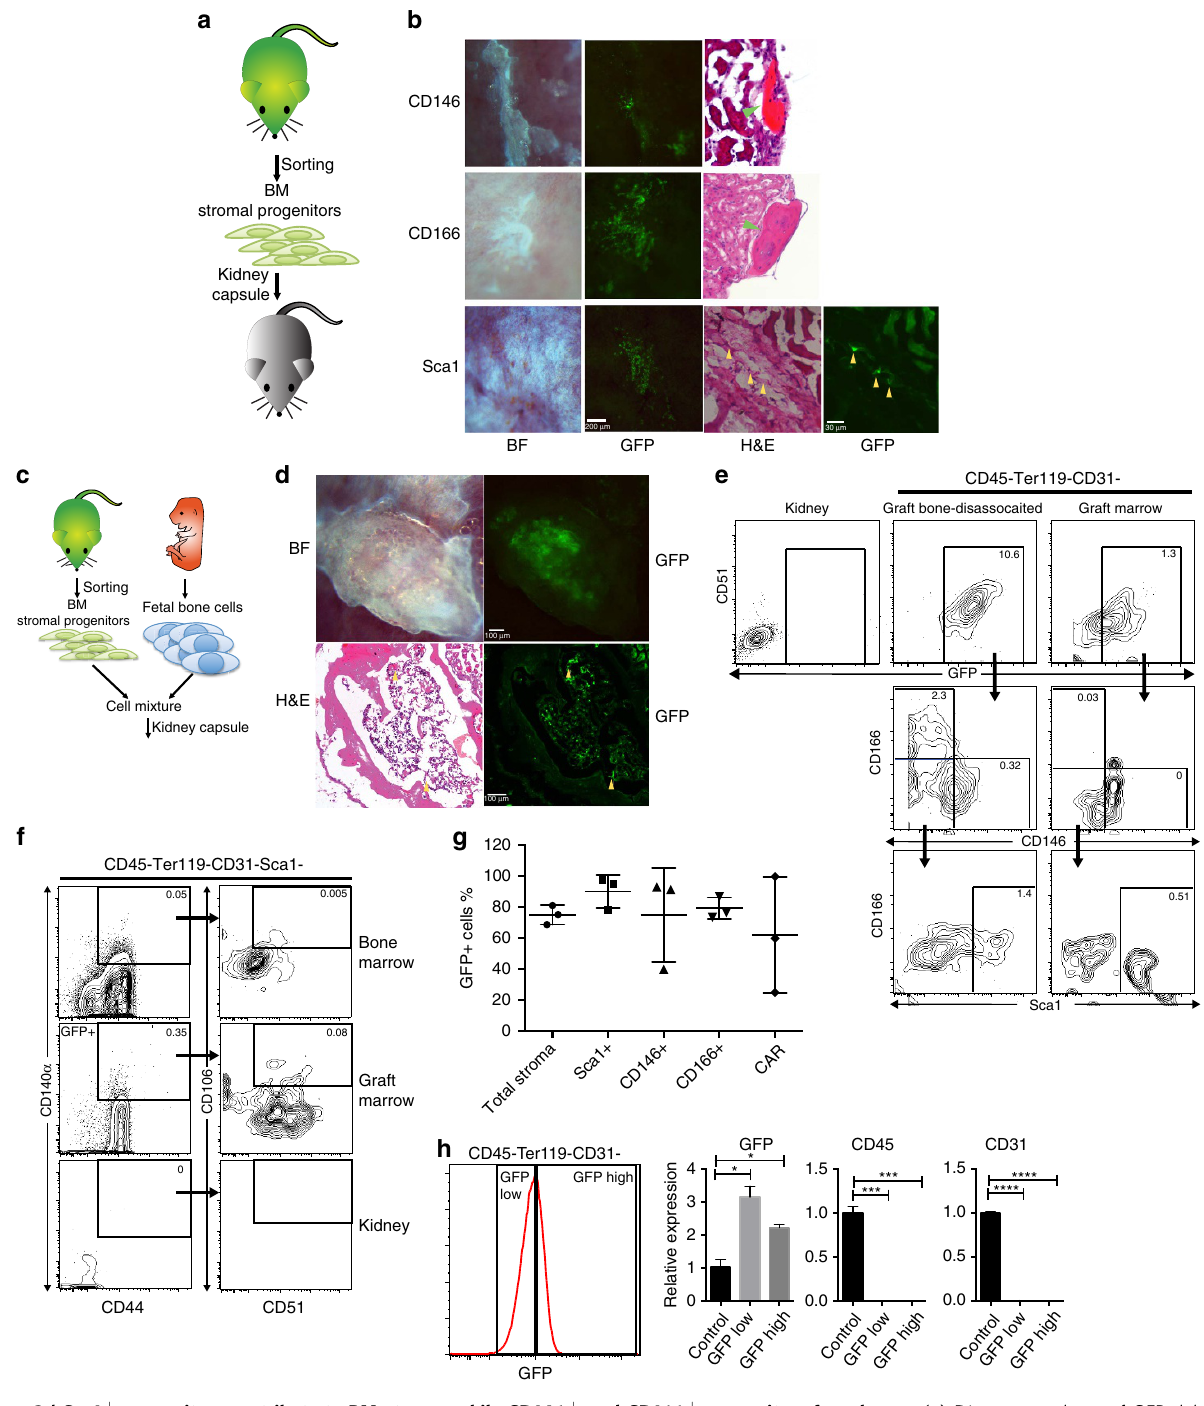
Figure 2 | Sca1 þ progenitors contribute to BM stroma, while CD146 þ and CD166 þ progenitors form bones. ( a ) Direct transplants of GFP- labelled progenitors under the kidney capsule. ( b ) Bright-field and GFP images of GFP-labelled progenitors 1 month after transplant (far left and left). A representative cross-section of the graft site was stained with H&E (right, green arrowhead points to bone) or GFP to identify the donor origin (far right, yellow arrowheads). ( c ) Co-tranplants of GFP-labelled adult progenitors with non-GFP fetal skeletal progenitors under the kidney capsule. ( d ) Bright-field and GFP images of GFP-labelled Sca1 þ mixed with fetal skeletal progenitors 1 month after transplant. Donor-derived GFP þ cells can be clearly identified (far left and left). Representative cross sections of the graft site stained with H&E (right) or GFP ( far right) to identify the donor origin (yellow arrowheads). ( e – f ) Representative FACS analysis of graft of mixed GFP-labelled Sca1 þ progenitors and non-GFP skeletal progenitors harvested 1 month after transplant. The per cent of live cells is displayed for each gate ( e ) FACS analysis of donor-derived endosteum associated progenitors (left) and marrow stromal cells (right). ( f ) FACS analysis for phenotypically defined CAR cells in control bone marrow, marrow of graft and kidney. ( g ) Percentage of GFP þ cells for each group; mean ± s.d. ( n ¼ 3). Total stroma is the Ter119-CD45-CD31- population. ( h ) Histrogram for GFP to show the populations that were sorted for RNA isolation (far left). Relative expression of GFP, CD45 and CD31 in control cells (untransplanted kidney), GFP low gate cells and GFP high gate cells (* P o 0.05, *** P o 0.0005, **** P o 0.00005, mean ± s.d., technical triplicate, student’s t